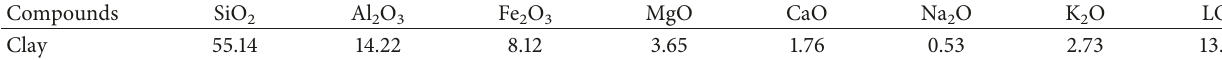
Table 1: Chemical composition of the raw material (wt.%).